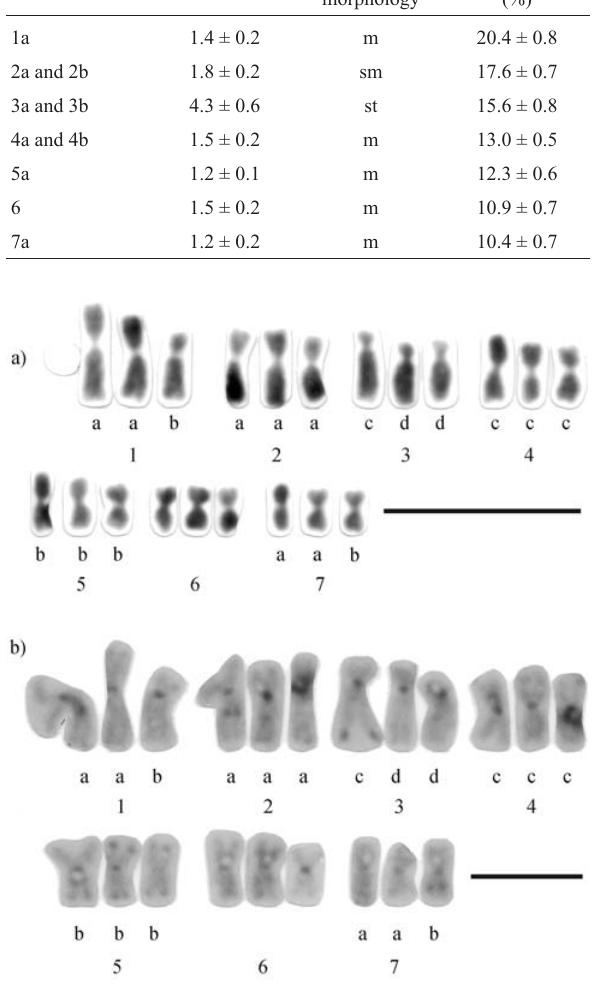
Figure 1 - Conventionally stained (a) and C-banded (b) diploid karyo- types of Dolichoplana carvalhoi (2n = 2x = 14). Bar 10 μ m. The letters under the chromosomes represent their variants.